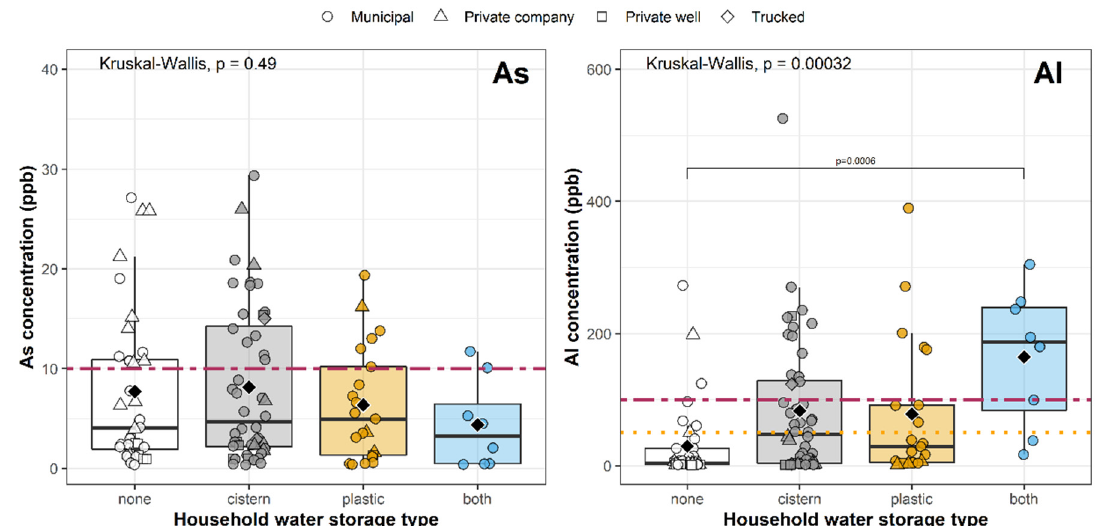
Figure 6. Distribution of As and Al concentrations in first-draw samples from households with and without onsite water storage. Horizontal lines of each box indicate the first quartile, median, and third quartile for each metal; vertical lines indicate the spread of the data up to ± 1.5 times the inter-quartile range. Black diamonds show the mean value. Dashed red lines indicate the MPL for As and Al. Dotted orange line indicates the MAL for Al. Pairwise comparisons highlight significant differences (adjusted for multiple comparisons) between water storage types using Wilcoxon tests. As showed no significant difference between water storage types, but Al did. Kruskal–Wallis tests eval- uate the overall significance of water storage on As and Al concentrations.